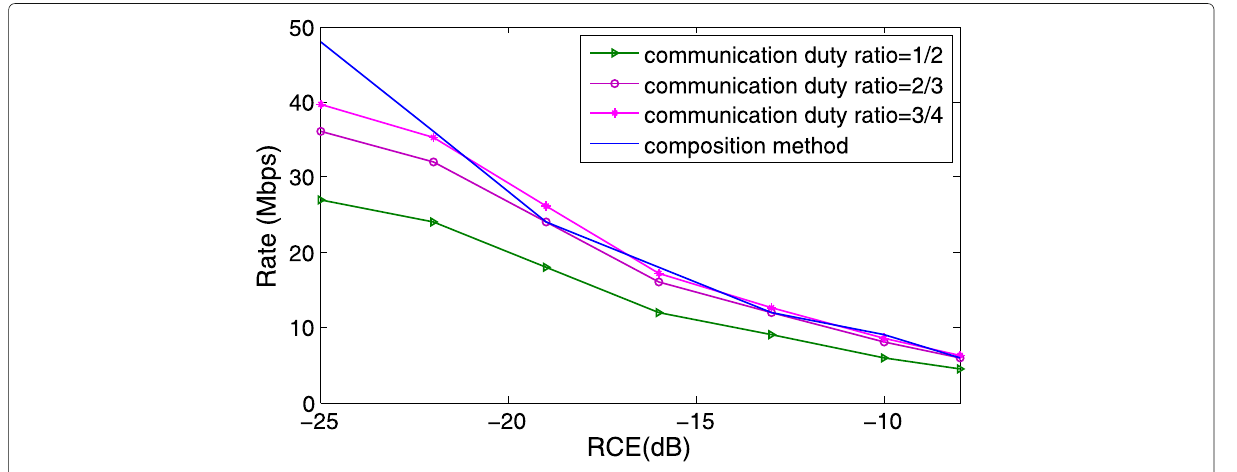
Fig. 8 Assessment of the composite method vs. time multiplex integration